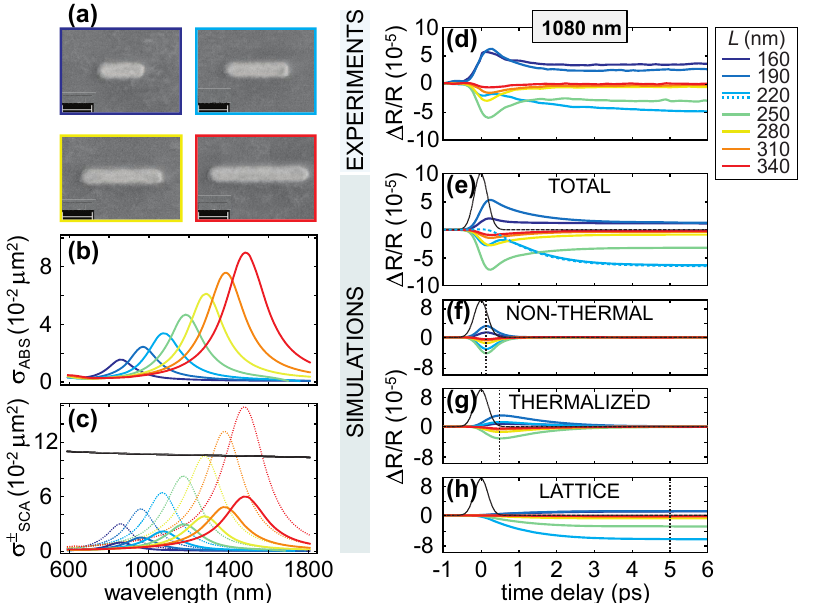
Figure 6: Ultrafast dynamics of hot electrons in Au single nanoantennas. (a) Scanning Electron Microscopy (SEM) images of the single Au nanoantennas of comparable width (50 nm) and different lengths L : 160 nm (dark blue), 220 nm (light blue), 280 nm (yellow) and 340 nm (red). Scale bar: 100 nm. (b and c) Simulated static spectra of the absorption (b) and both backward (solid lines) and forward (dotted lines) scattering cross-sections (c) of nanoantennas with different lengths. Black solid line represents the equivalent backward scattering cross-section from the substrate for a probe beam with 1- μ m spot radius. (d–h), Experimental (d) and simulated (e) Δ R ∕ R time traces at 1080 nm probe wavelength for nanoantennas of different length. The total simulated Δ R ∕ R signal from each nanoantenna is further disentangled in terms of the contributions arising from non-thermal electrons (f) thermalized electrons (g) and the lattice (h). Dashed line in (e) represents the simulated Δ R ∕ R for the 220-nm-long nanoantenna neglecting the contribution from non-thermal electrons. Dotted lines in (e–h) are the pump-probe cross-correlation assumed in the simulations (corresponding to the dynamics of the driving term in the 3TM). Vertical dashed lines in (f–h) indicate the time delay at which the disentangled Δ R ∕ R signal is maximum. Adapted with permission from ref. [94]. Copyright 2015, American Chemical